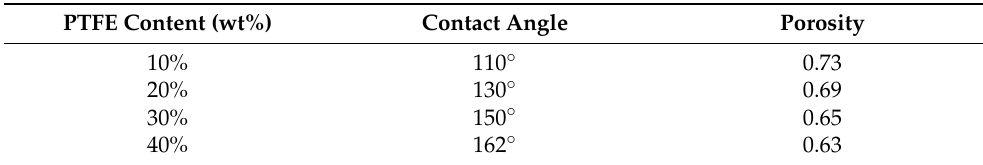
Table 1. Effects of PTFE content on the GDL characteristics.